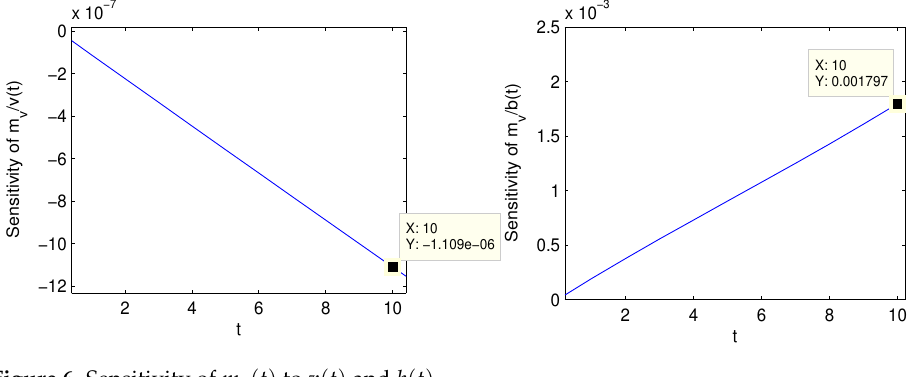
Figure 6. Sensitivity of m v ( t ) to v ( t ) and b ( t ) .